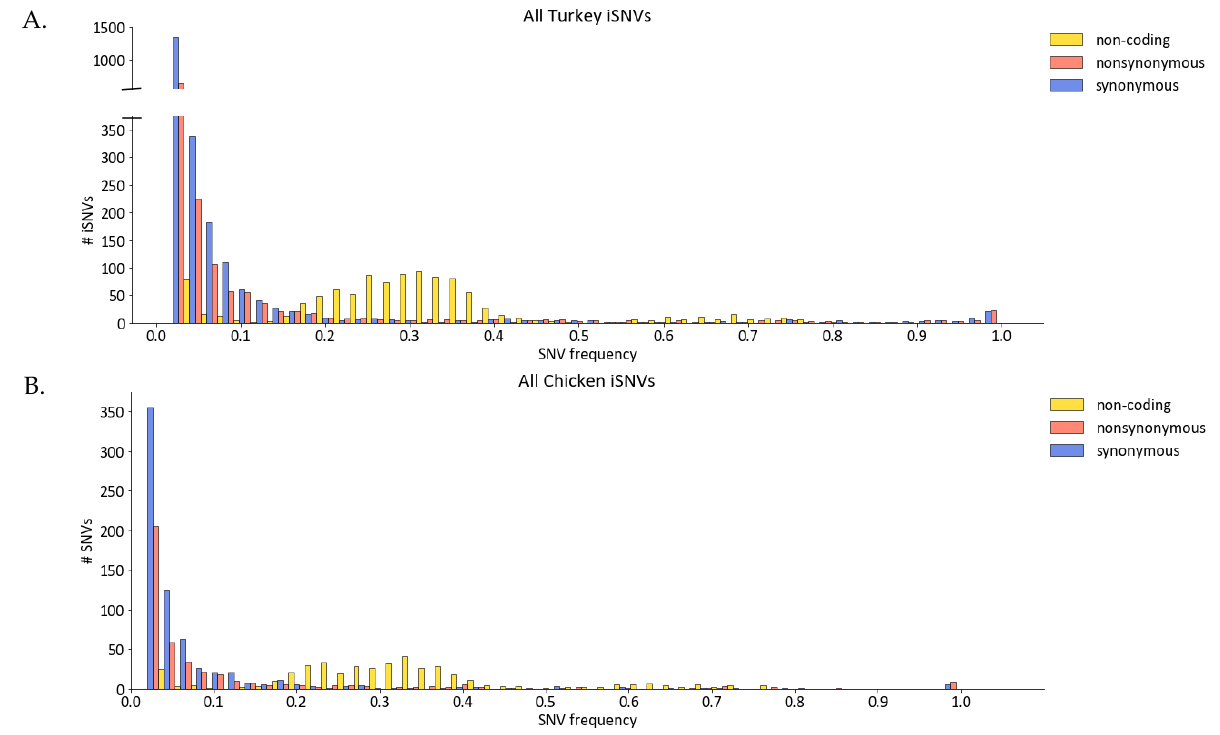
Figure 1. Histogram of iSNVs observed in samples from turkeys ( A ) and chickens ( B ) experimentally infected with the H7N3 AIVs. Each iSNV was classified as a nonsynonymous mutation if it resulted in an amino acid change in at least one viral protein.